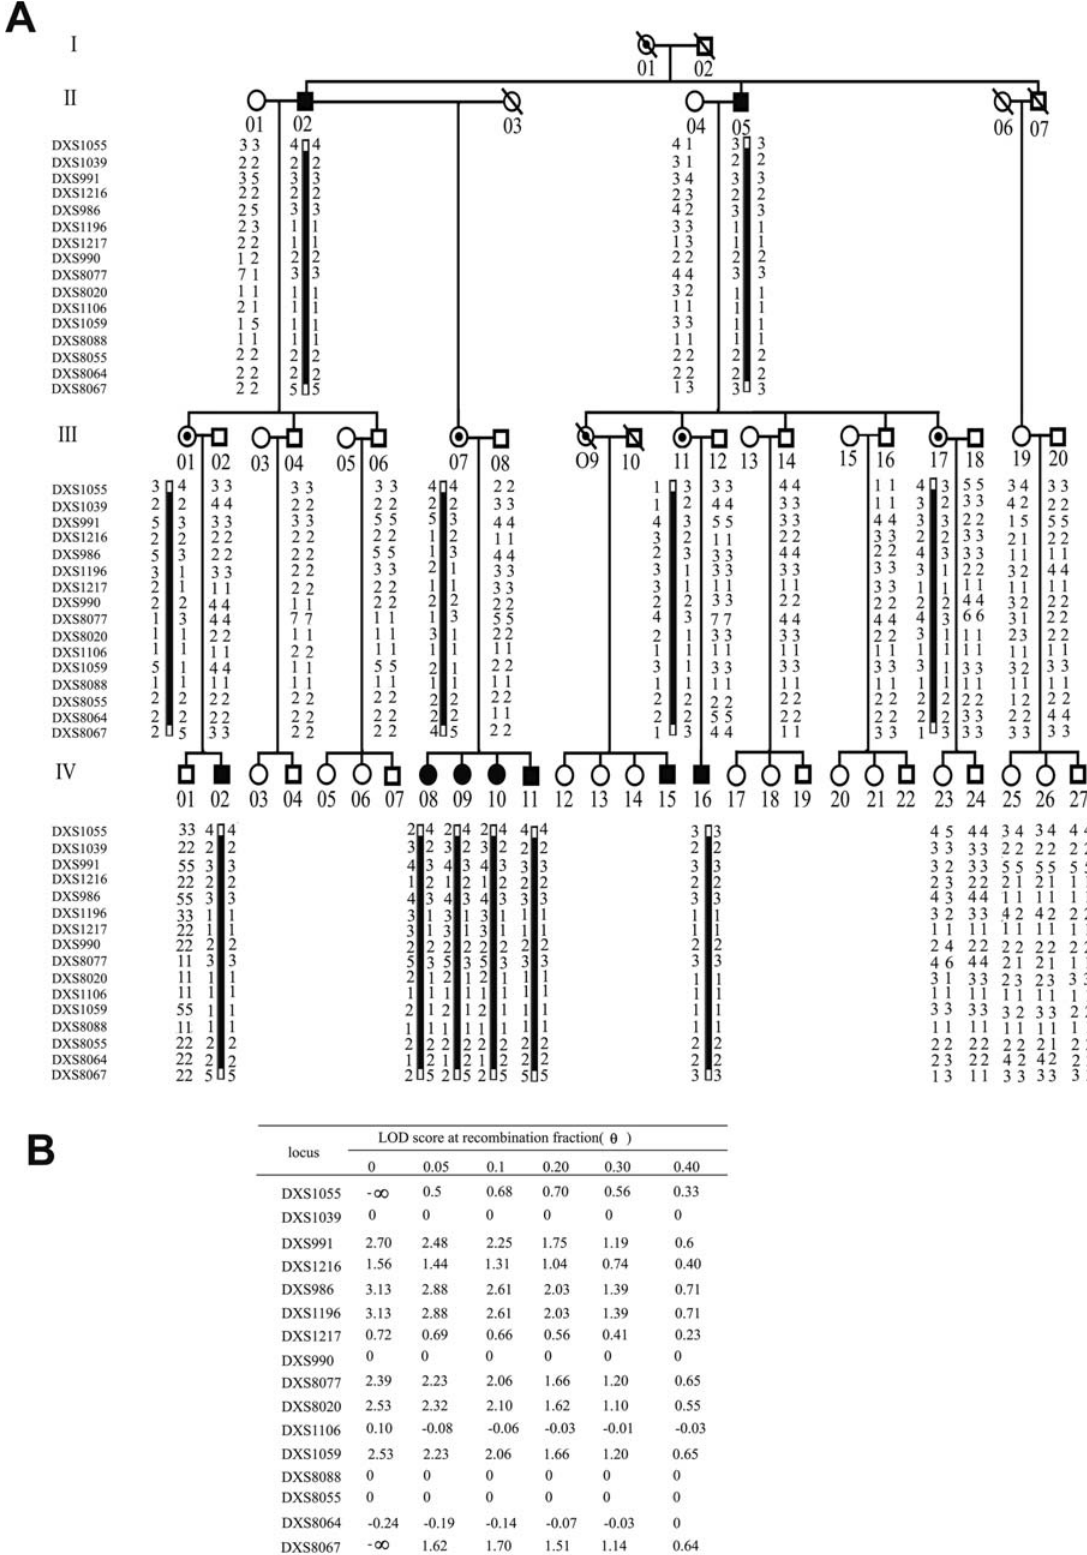
Figure 3. Linkage analysis for Family A. (A). Haplotype analysis in the Family A. Open symbols represent the unaffected individuals, closed symbols represent the affected individuals, squares indicate men, and circles indicate women. The closed bars indicate the fourteen contiguous- marker disease-linked haplotypes shared by all patients and female carriers. (B).The Lod Score obtained from the analysis of the pedigree of Family A with X-linked microsatellite markers around the centromere.